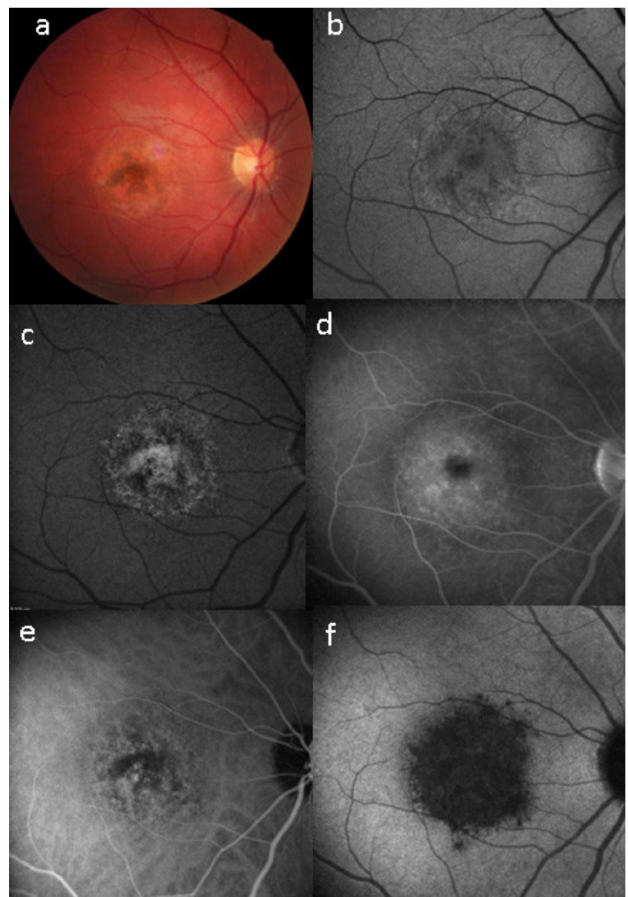
Figure 33. Case of UIAM at presentation: ( a ) fundus photography showing a reddish foveal de- tachment surrounded with an irregular, circular area of greyish RPE discoloration. ( b ) BL-FAF shows a light hypoautofluorescence in the macular area. ( c , d ) FA early and late phases reveal late hyperfluorescence due to the leakage and pooling in the neurosensory foveal detachment. ( e , f ) ICGA early and late phases reveal persistent hypofluorescent area surrounded, in the late frame, by a hyperfluorescent ring, sign of hyperpermeability of the choroidal